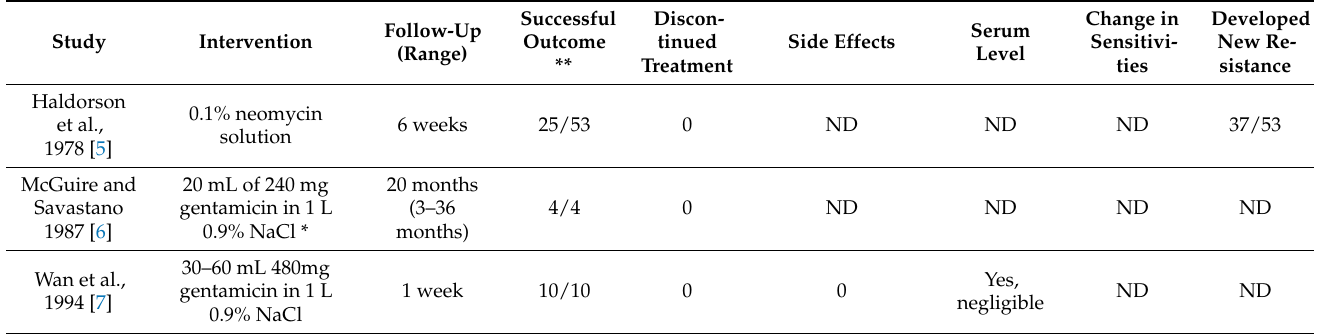
Table 3. Administration, outcomes, and safety of use of intravesical aminoglycosides for